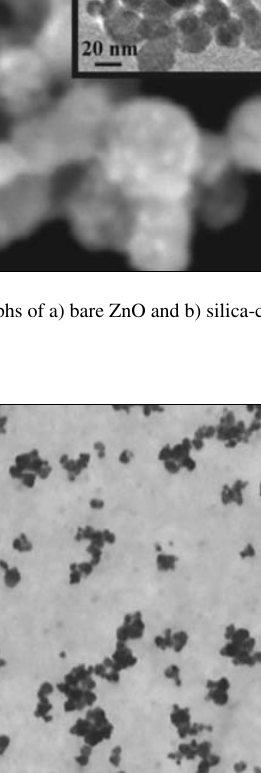
Figure 3. ZnO distribution in PMMA (STEM image)